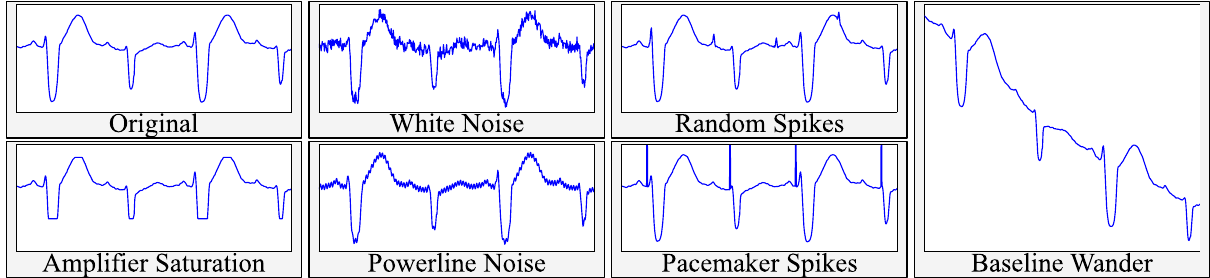
Figure 3. Data augmentation strategy example for an ECG recording. Re-execution results in slight signal-to- noise ratio (SNR) and frequency ( f ) variations, altering the final shape of the computed noise.